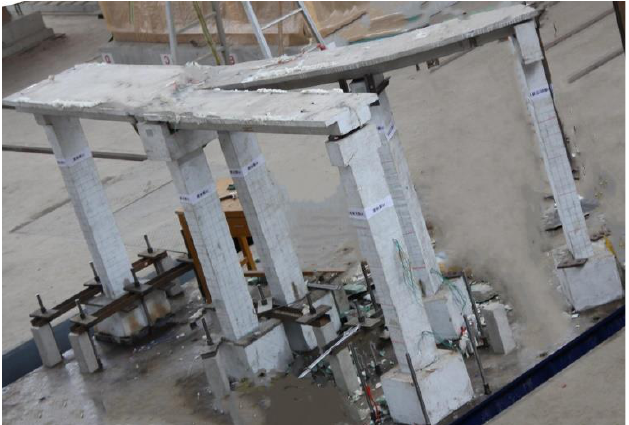
Figure 3. Bridge model on the shaking table.